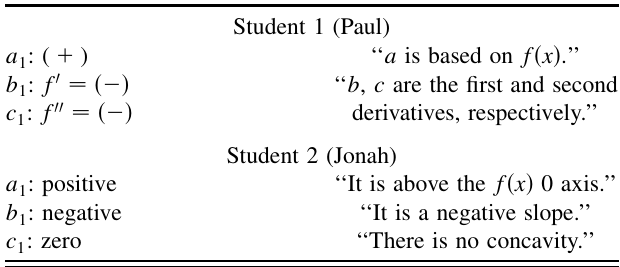
TABLE II. Examples of correct student responses on the Taylor series pretest. (All student names are